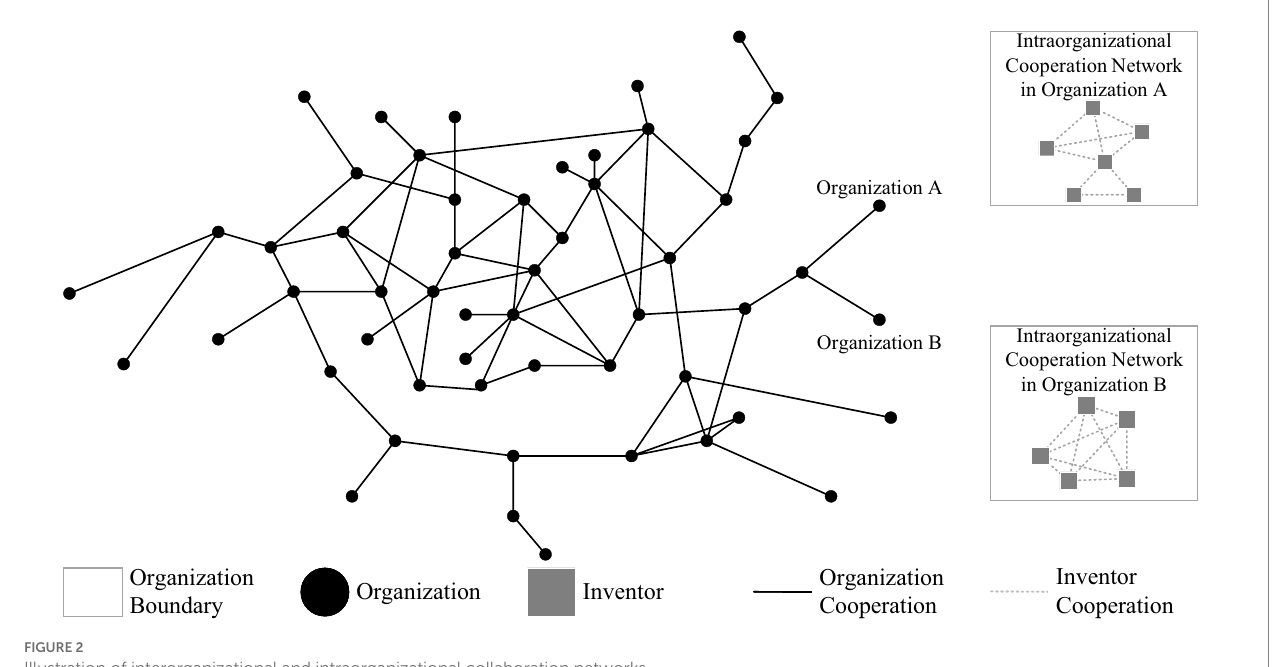
FIGURE 2 Illustration of interorganizational and intraorganizational collaboration